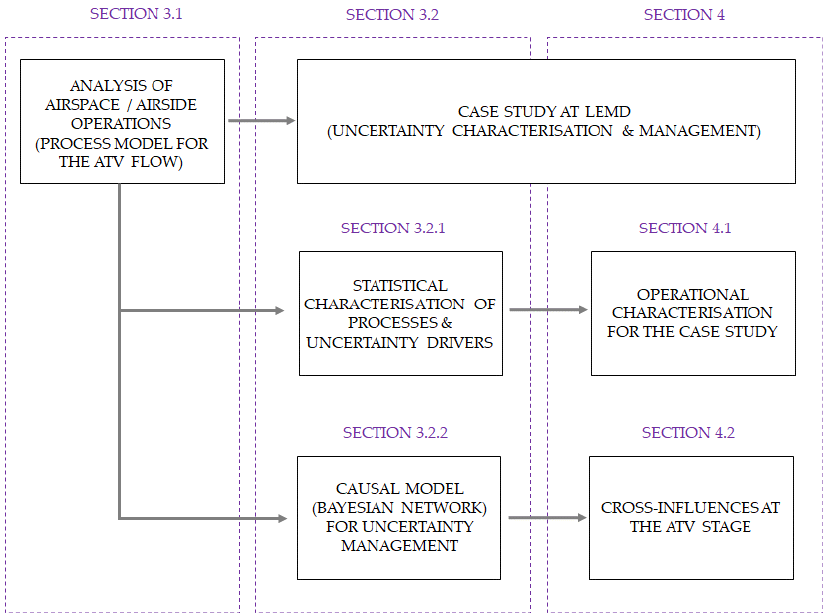
Figure 16. Linkage between the methodological approach and the results.